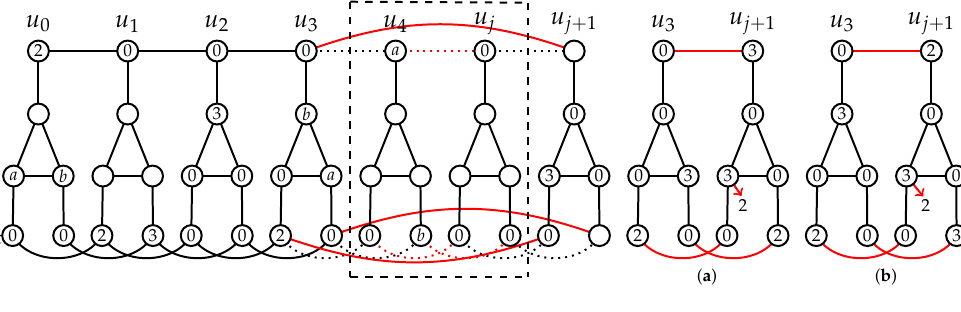
Figure 12. Case 2.3 of Lemma 9: f ( v j + 1 + 2 k ) =